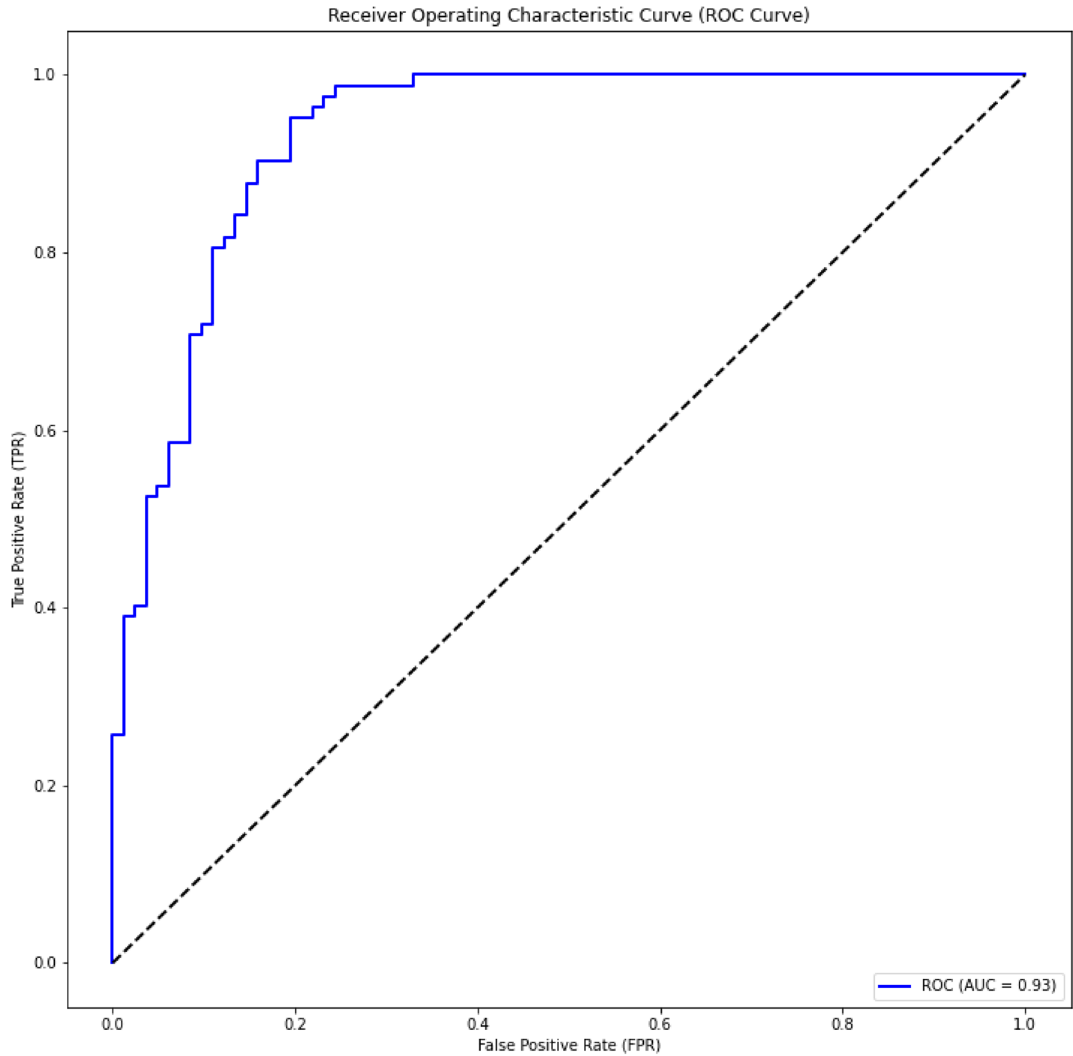
Figure 4. ROC curve for ACP-500/164. Here we used ACP-500 as a training dataset and ACP-164 as a testing dataset on the experiment.